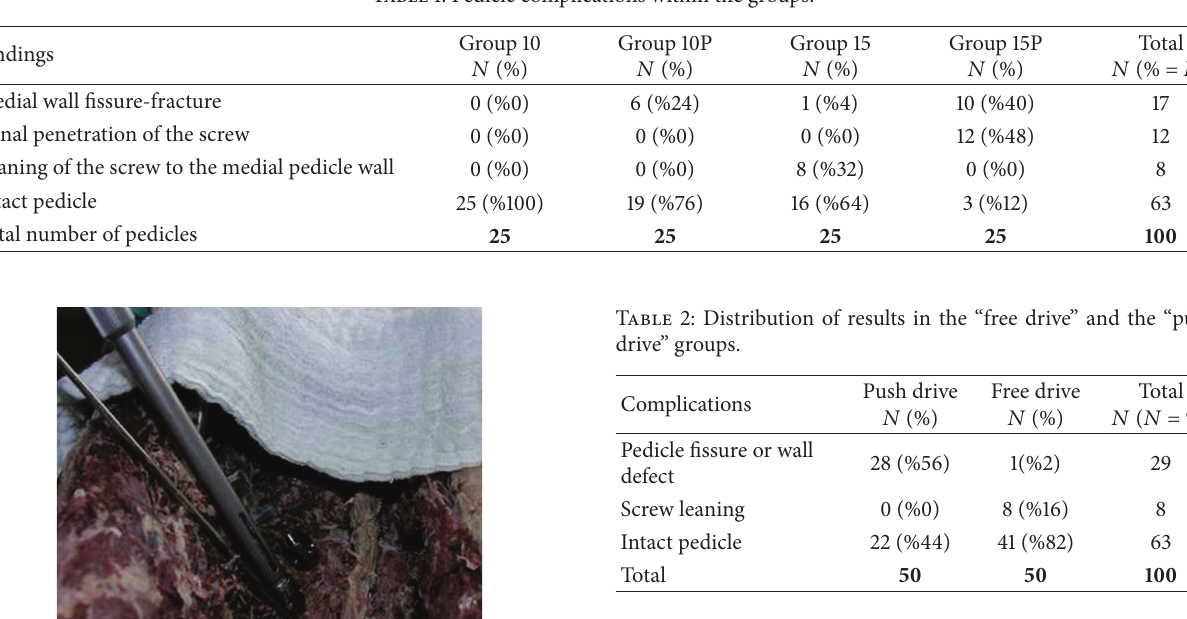
Table 1: Pedicle complications within the groups.